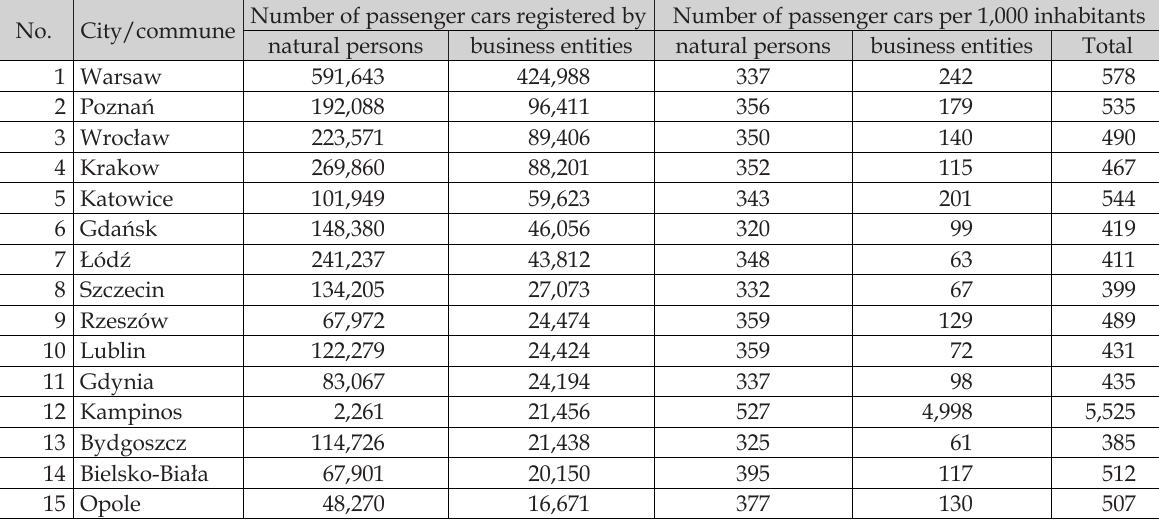
Table 3. The 15 cities and communes in Poland with the largest number of company cars.